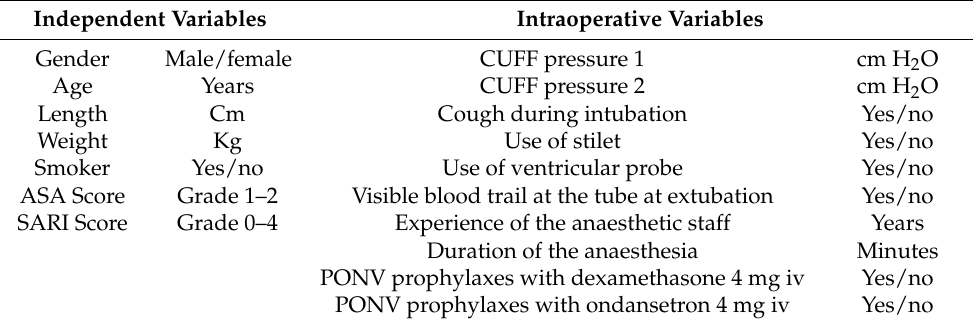
Table 1. Collected variables.